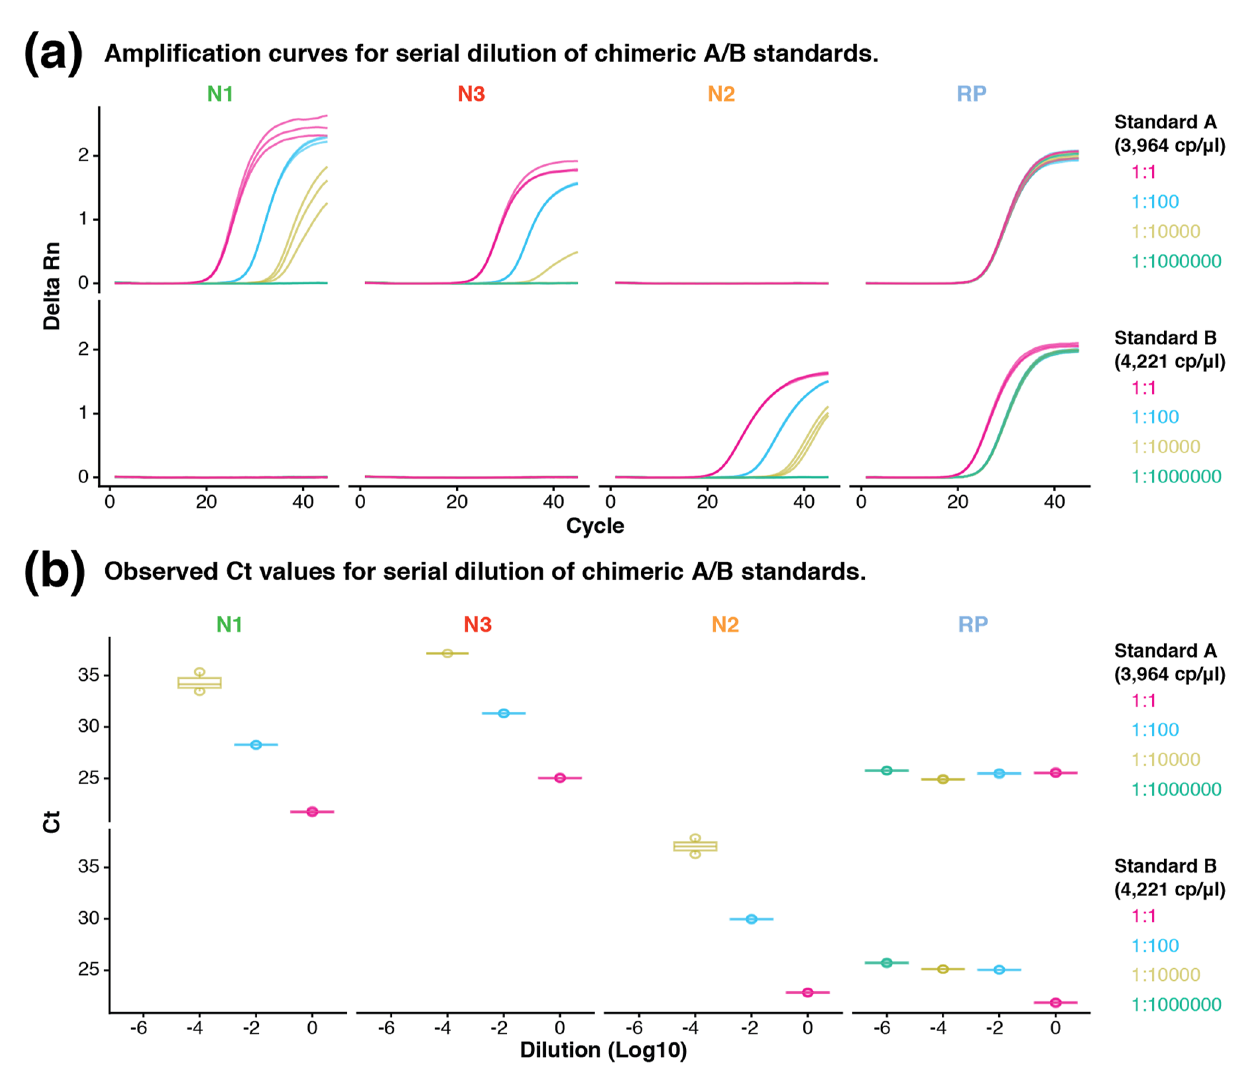
Figure 3. Limit of detection of chimeric A/B standards. ( a ) Amplification curves of targets N1, N2, N3 and RP in 100-fold serial dilutions of standards A and B against the human universal RNA, with three technical replicates. ( b ) Observed Ct values for targets N1, N2, N3 and RP at different dilutions of standards A and B (10 0 , 10 –2 , 10 –4 and 10 –6 ), across three technical